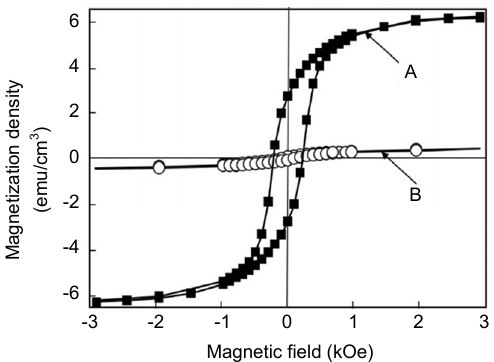
Fig. 6 | Magnetization curve for the SiC crystals, measured a t 27 ℃ . Closed squares and open circles are the results acquired after and before the DP-assisted annealing, respectively. They are fitted by the curves A and B,